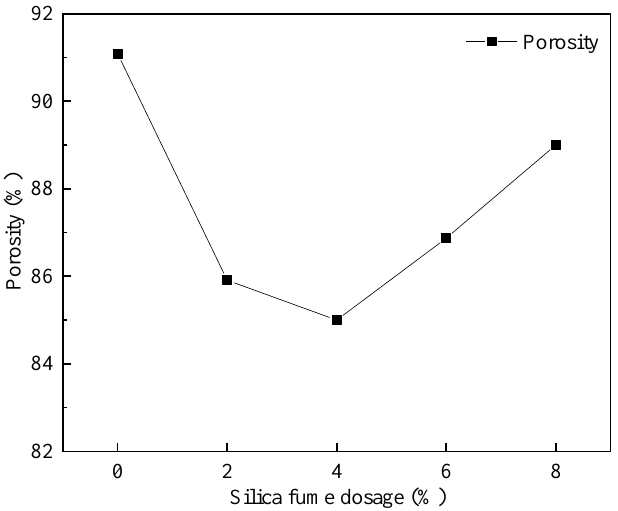
Figure 16. Effect of silica fume dosing on porosity.